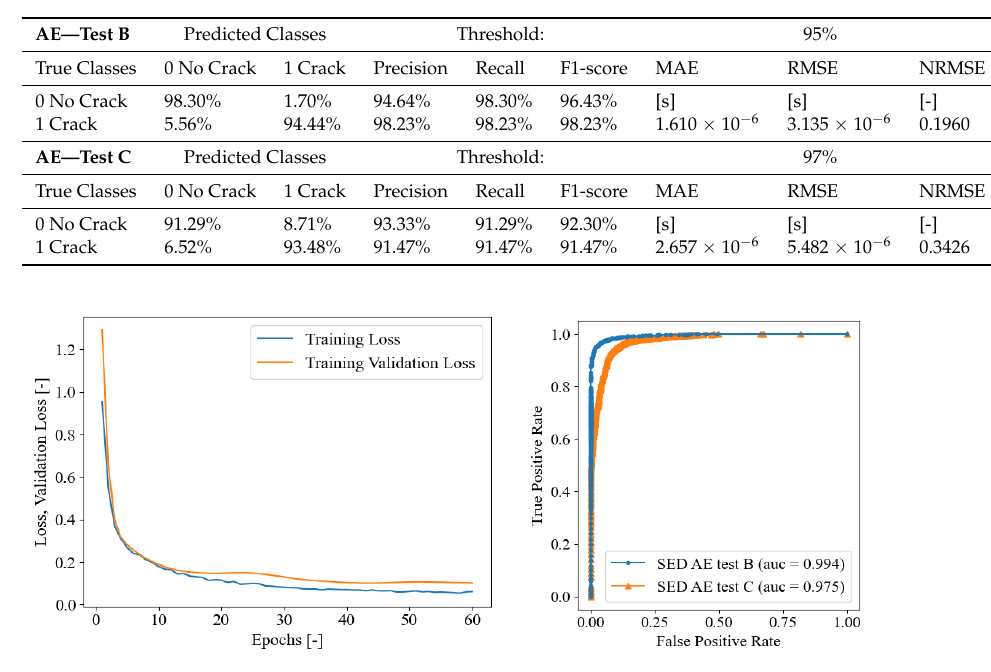
Figure 10. On the left : Fine-tuned SED, training loss convergence curves. On the right : ROC curve for AE PLB test set B and C.